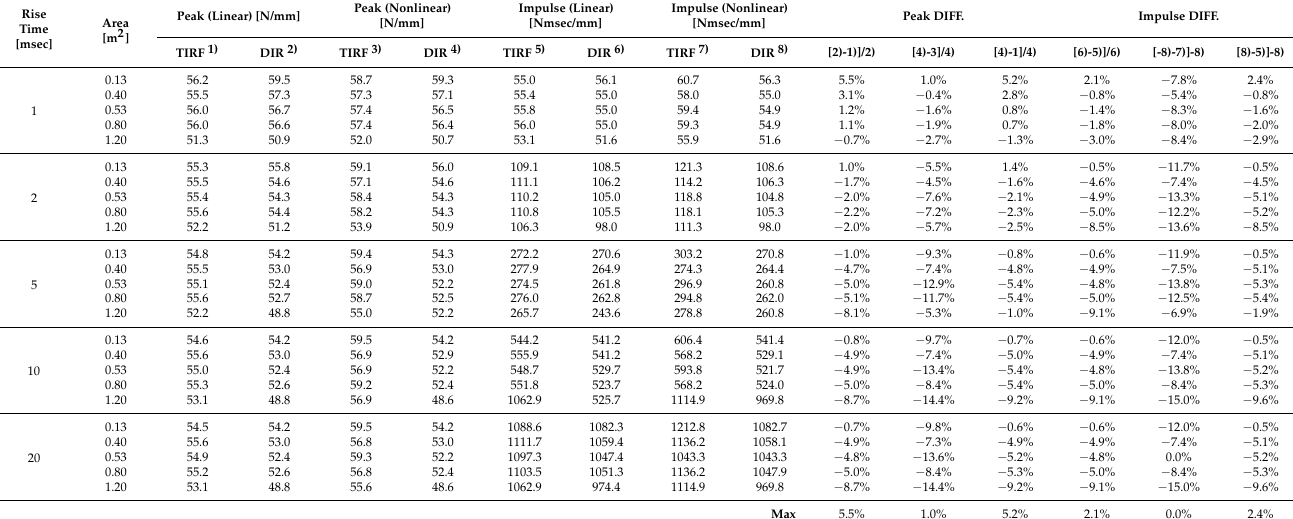
Table 6. Shear responses for LNG cargo containment boxes (Model